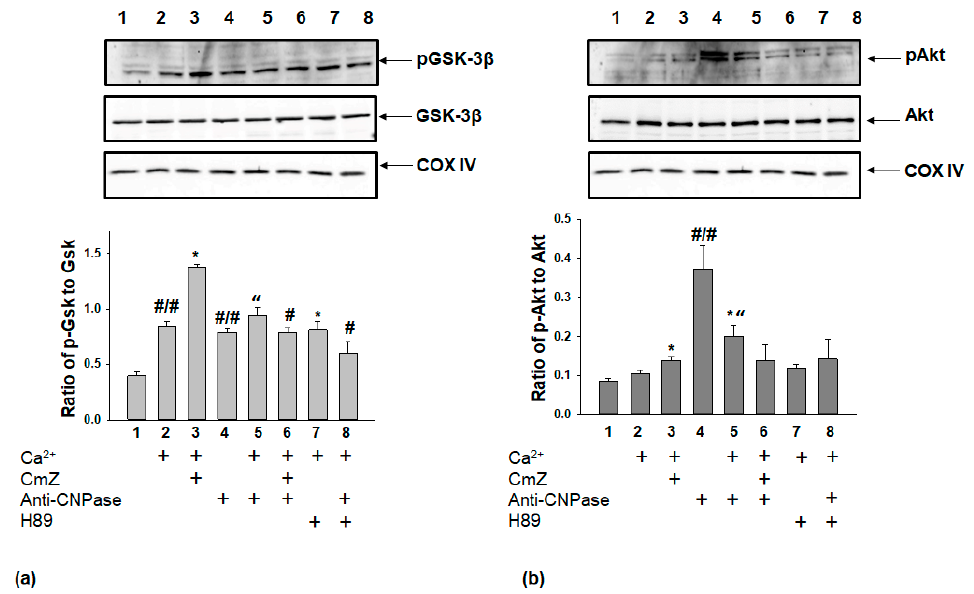
Figure 4. The phosphorylation states of stress-activated protein kinases (GSK3 β and Akt) in RBM. ( a ) The ratio of pGSK3 β to total GSK3 β . ( b ) The ratio of pAkt to total Akt. Upper parts represent Western blots of a mitochondrial suspension after the isolation of RBM (see Section 4). Membranes were stained with antibody specific to pGSK3 β , GSK3 β , pAkt, and Akt. Lower parts—quantitation of immunostaining using computer-assisted densitometry. Bar graphs represent the ratios of pGSK3 β to total GSK3 β ( a ) and of pAkt to total Akt ( b ) in RBM after the addition of CmZ (30 µ M), H89 (5 µ M), and anti-CNPase antibody (0.18 µ g/mL). The protein band intensity was quantified after normalization with respect to Cytochrome c oxidase subunit IV (COX IV). The values shown are the means ± SD from three independent experiments; #/# p ≤ 0.05 vs. the pGSK3 β /GSK3 β ratio without any additions, * p ≤ 0.05 vs. pGSK3 β /GSK3 β ratio in the presence of Ca 2+ , “ p ≤ 0.05 vs. pGSK3 β /GSK3 β ratio in the presence of anti-CNPase antibody, # p —versus pGSK3 β /GSK3 β ratio in the presence of anti-CNPase antibody and Ca 2+ .